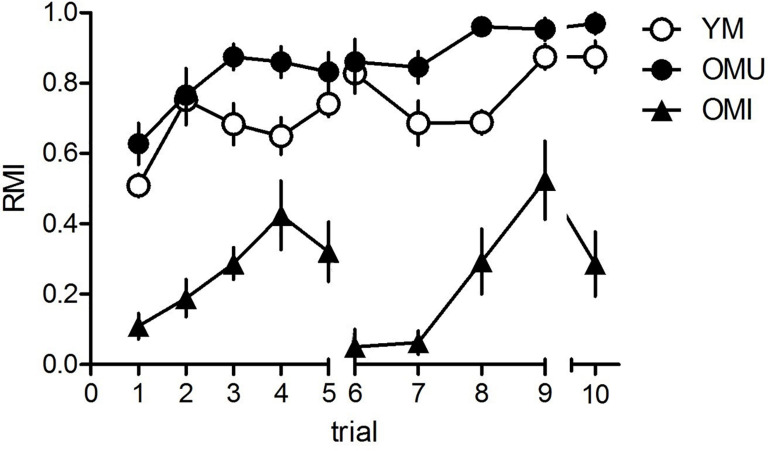
Behavioral results for the hole-board test. Young males (YM) performed better than old impaired males (OMI) showing higher reference memory indices (RMI) but not compared to old unimpaired males (OMI) whereas between YM and OMU there was no difference (for statistics see the section “Results”). Given are the mean values and standard errors of the mean, n = 10 for each group). Statistics: 10 animals per group; data analyzed by SPSS Version 22 software (IBM® SPSS® Statistics) using general linear model – repeated measures ANOVA; the significance cut-off was set at p < 0.05. Spatial memory performance was evaluated based on reference memory index (RMI) calculated as following: (first + revisits of baited holes)/total visits of all holes; good performers if RMI > (the mean RMI value + standard deviation); bad performers when RMI < (the mean RMI value – standard deviation); the mean value obtained from all animals included in the analysis over the evaluated training/testing period. The values are expressed as mean ± SEM.